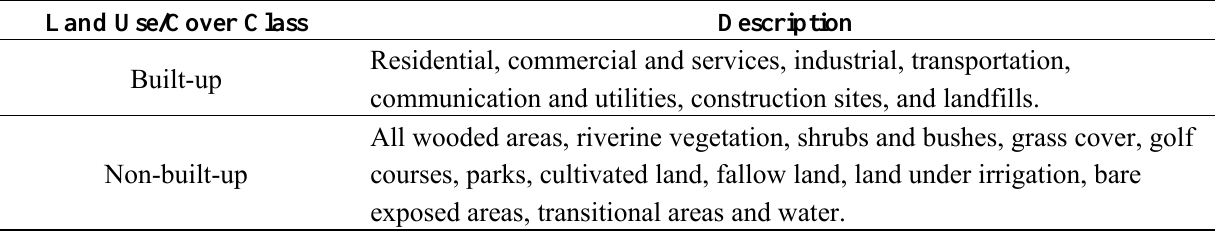
Table 2. Land use/cover classes.